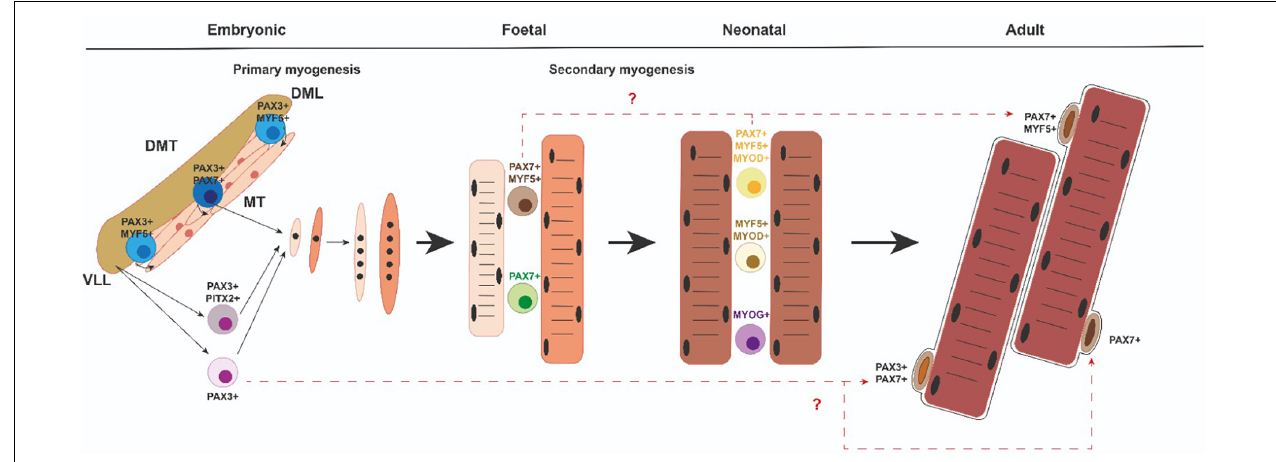
FIGURE 2 | Myogenic progenitors and satellite cells. Diverse myogenic cell populations emerging in the course of developmental and neonatal myogenesis could give rise to different subsets of SC within adult muscle. DMT, dermomyotome; MT, myotome; DML dorsomedial lip of the dermomyotome; VLL, ventrolateral lip of the